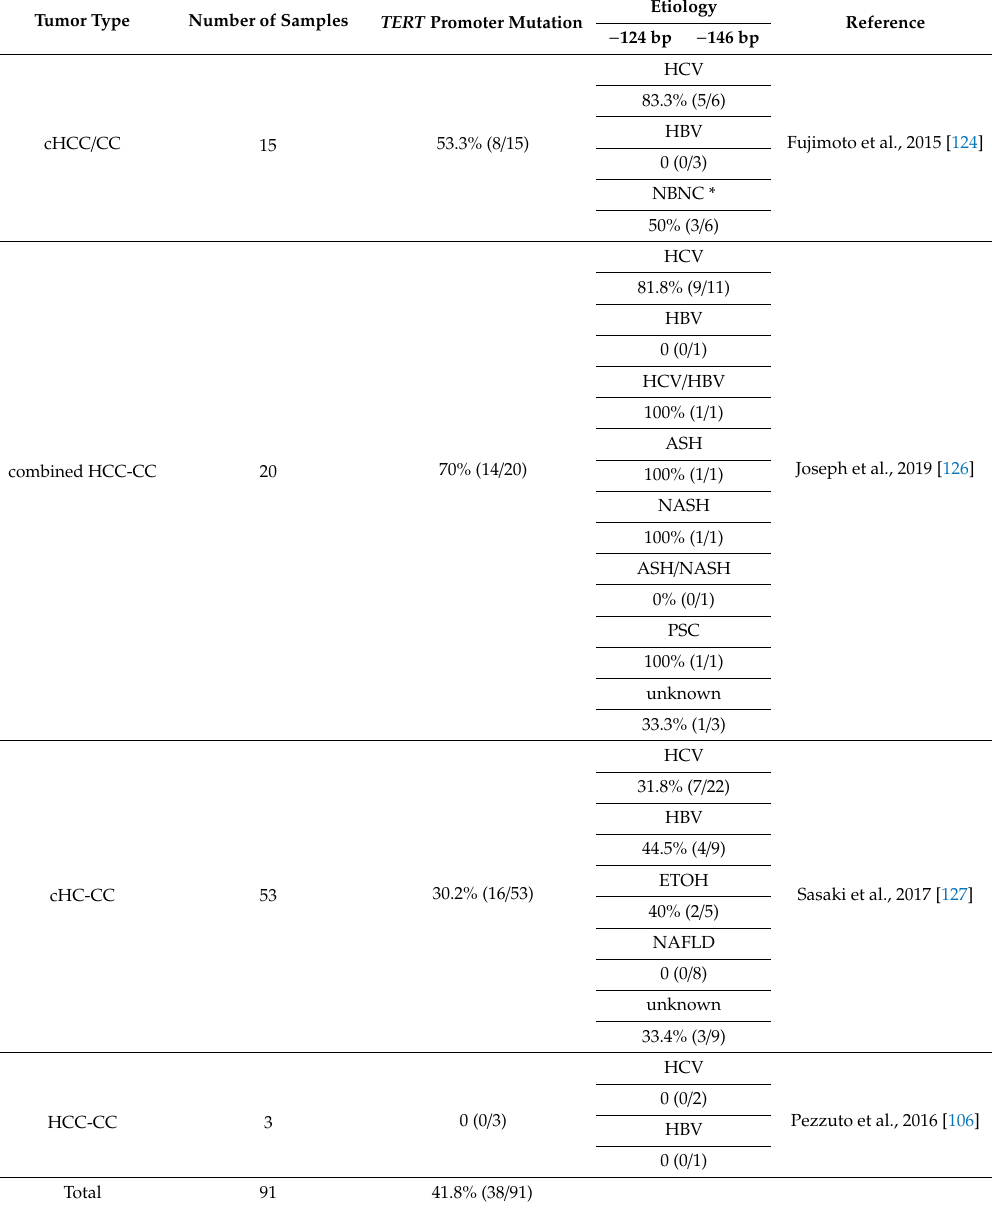
Table 3. TERT promoter mutations in combined HCC / iCCA.